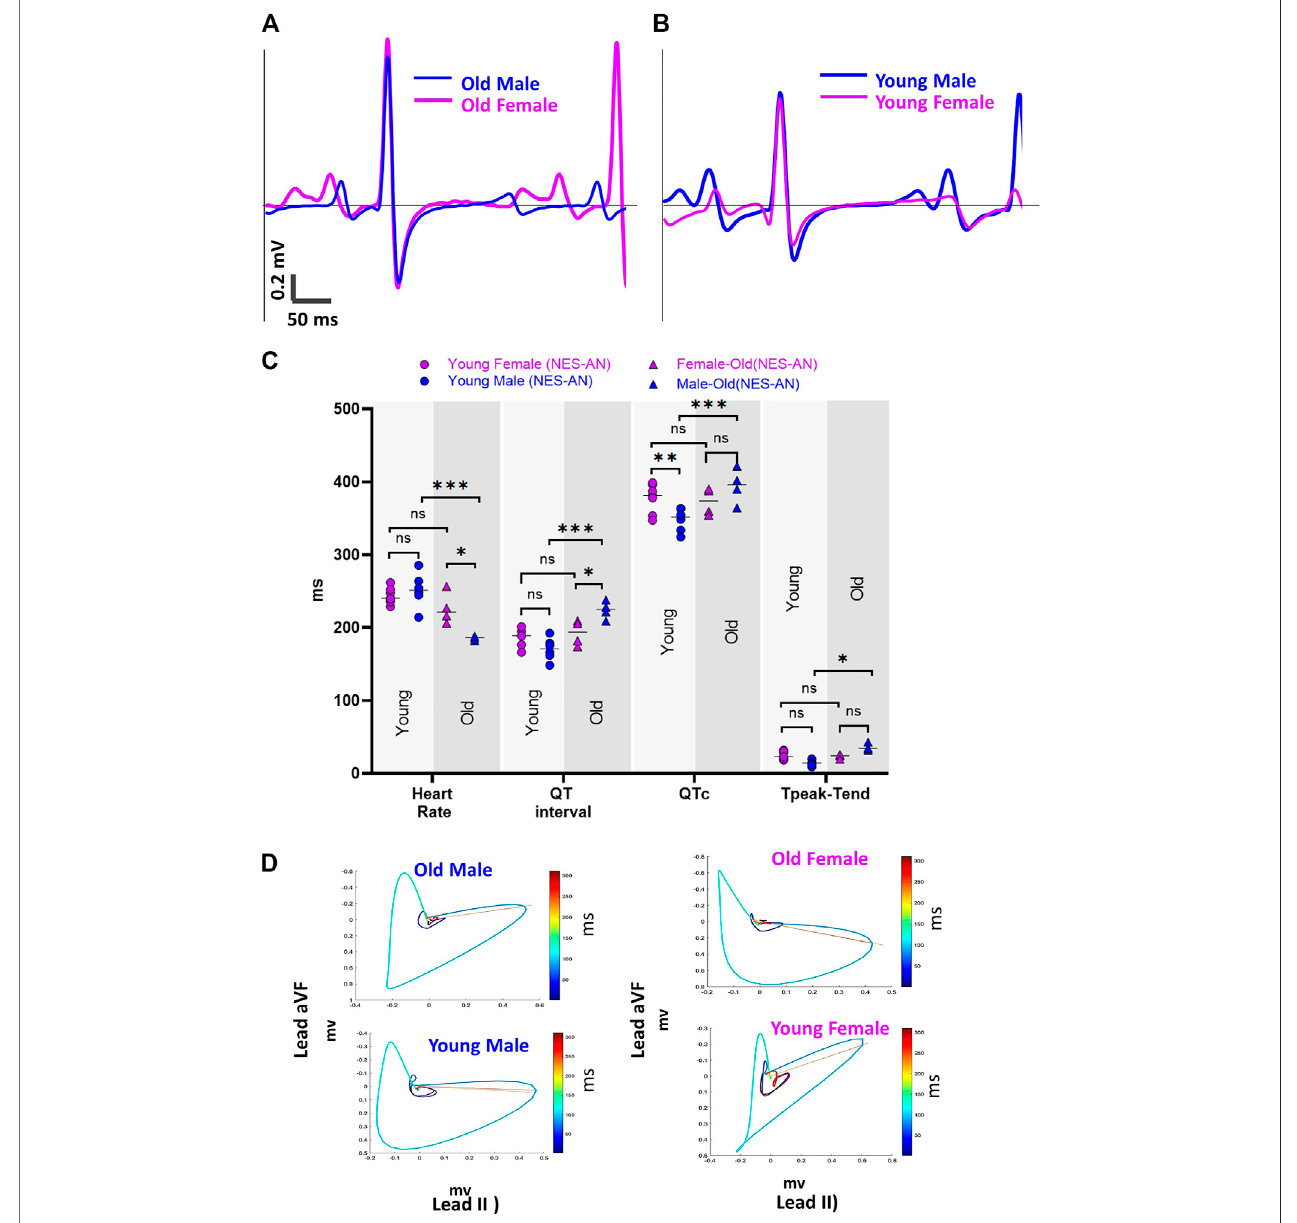
FIGURE 6 | Sex effect on ECG parameters. (A) Example lead I ECG traces from an old male and old female guinea pig in NES-AN. (B) Example lead I ECG traces from a young male and young female guinea pig in NES-AN. (C). Comparison of ECG parameters in males ( n = 4) and females ( n = 4) in old and young age groups. (D). Example VCG loops from a male and female animal from old and young age groups. 2-way ANOVA with 0.05 FDR cutoff was used to calculate the p values. p p < 0.05, pp p < 0.01, ppp p < 0.001, pppp p < 0.0001.